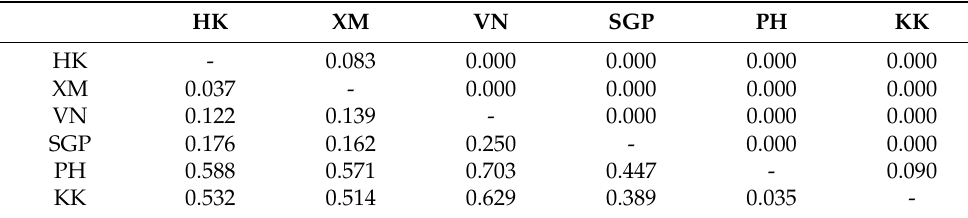
Table 2. Matrix of pairwise F ST (below diagonal) and p -values (above diagonal) among 6 populations of Portunus pelagicus in Southeast Asia.